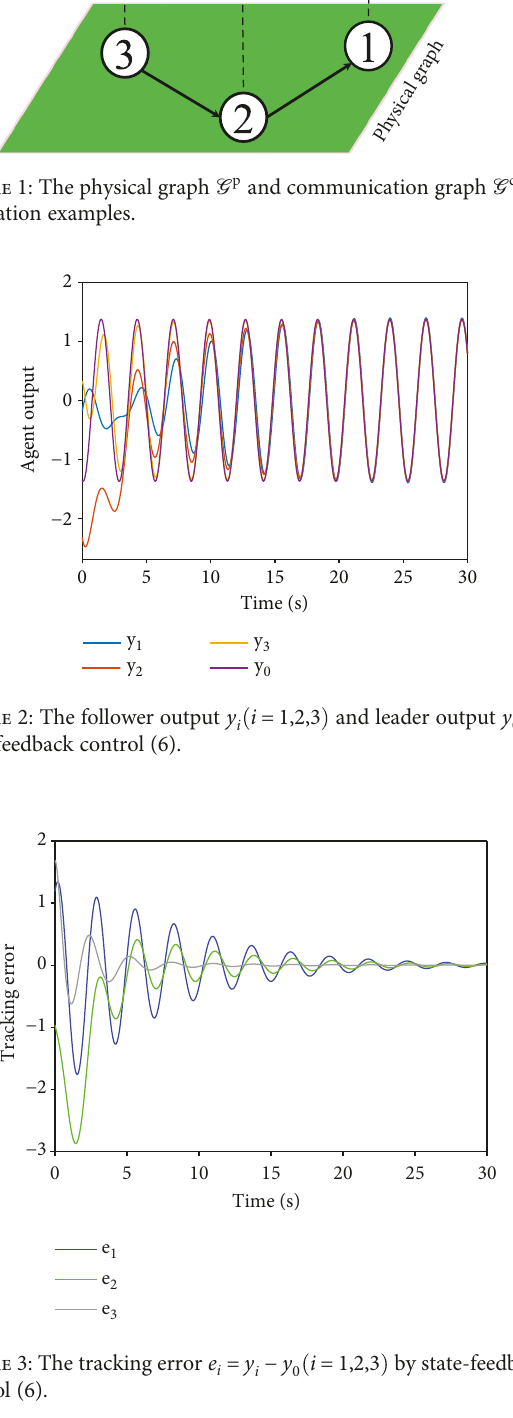
Figure 3: The tracking error e control (6).